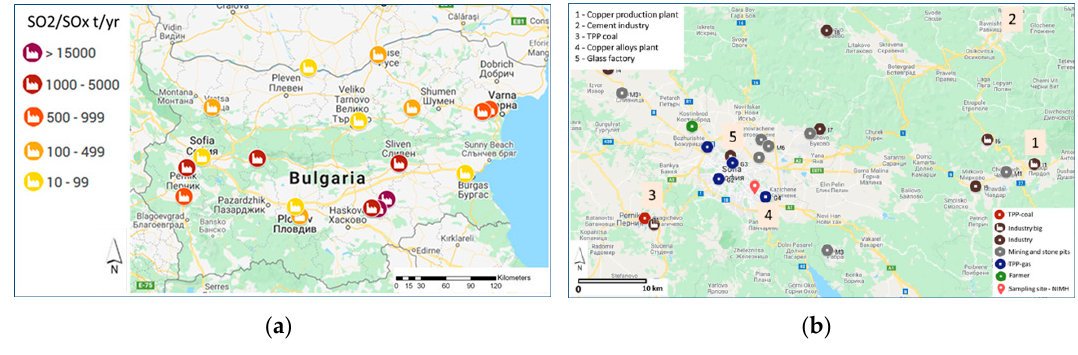
Figure 1. Maps with main point source of SO2/SOx ( a ) and PM10 ( b ) .